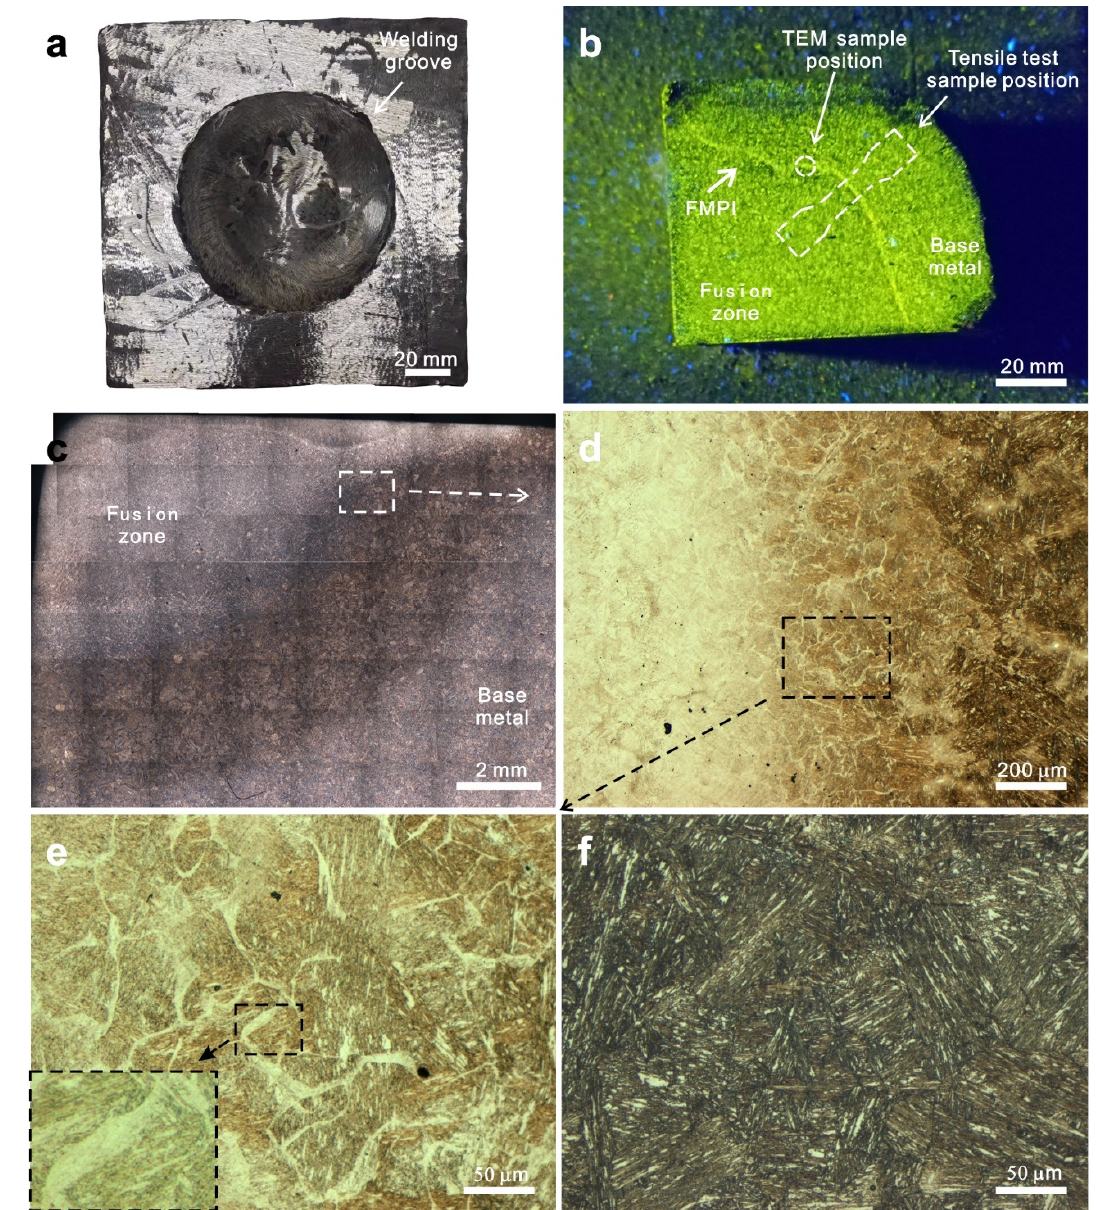
Figure 1. ( a ) The workpiece with the U-shaped groove used for welding test. ( b ) Fluorescent magnetic particle indication on the welded workpiece. ( c ) Optical micrographs of the macrosection of the welding repaired zone. ( d ) High magnification optical micrographs of the weld fusion line. ( e ) High magnification optical micrographs of the aera indicated by the black dotted box in ( d ). ( f ) Optical micrographs of base metal. Note that, for convenience of fluorescent magnetic particle testing, only 1/4 part of the welded workpiece was used in ( b ). The position of TEM samples and tensile test samples of the materials after welding are indicated in ( b ).